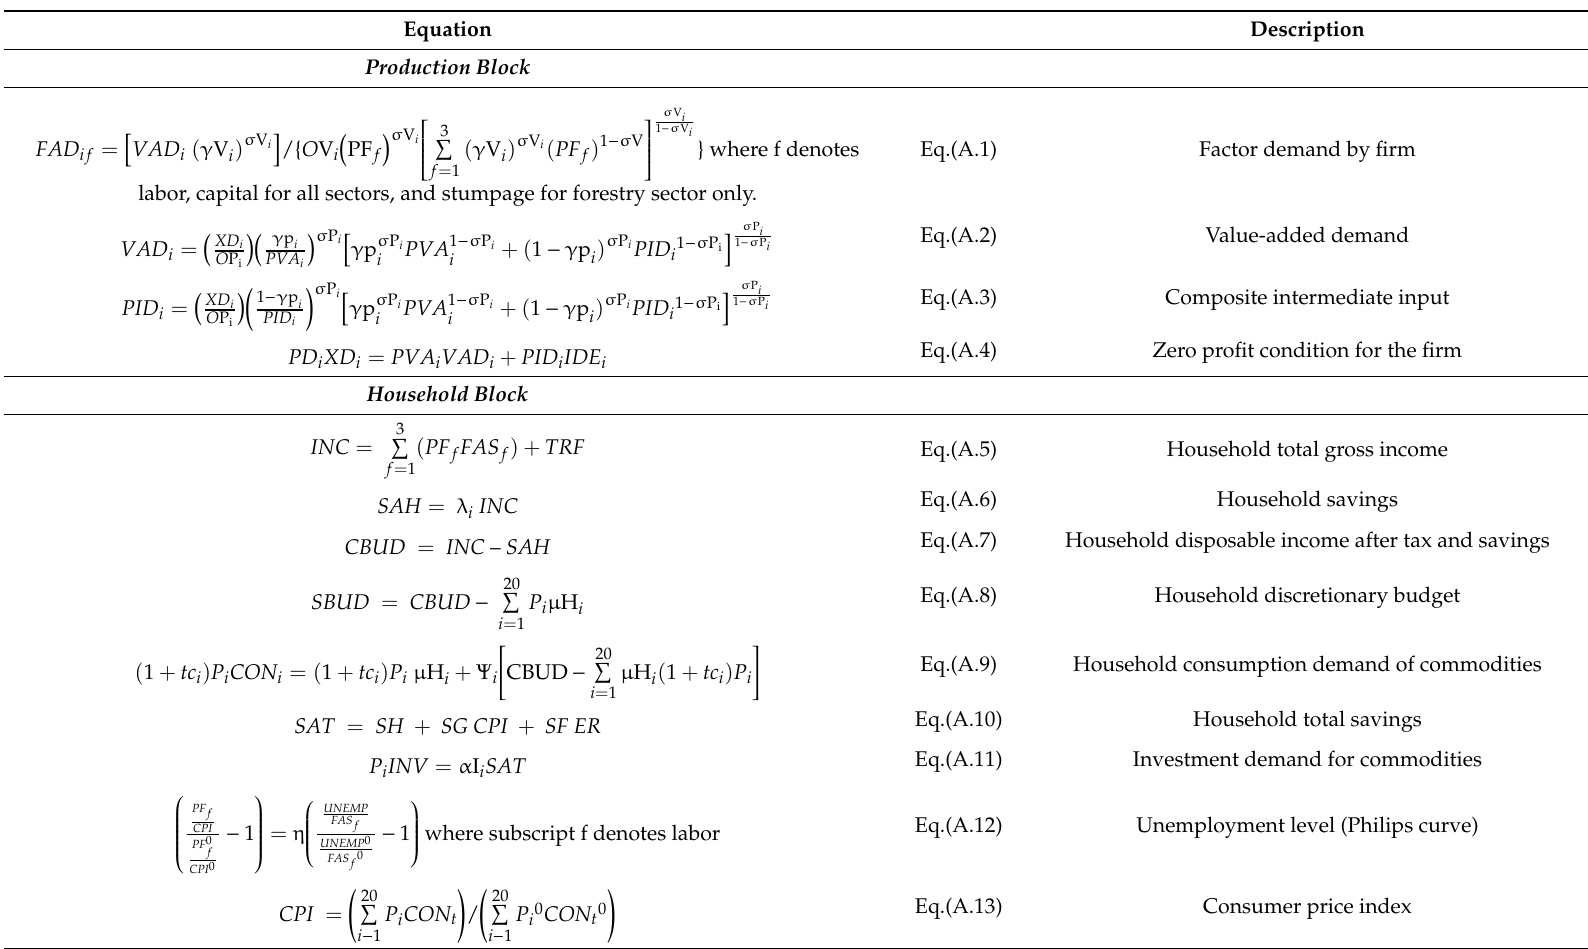
Table A3. CGE model